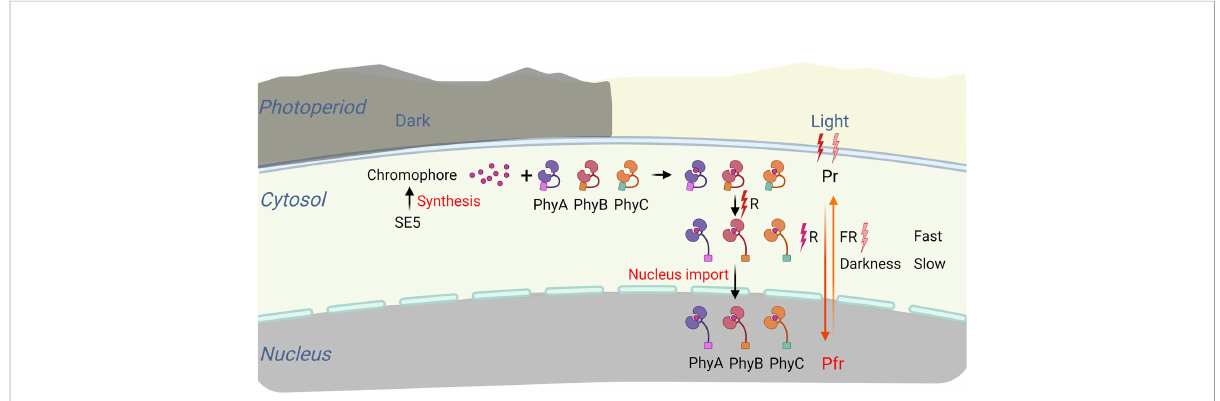
FIGURE 3 Phytochromes import to the nucleus after converting from inactive Pr form to active Pfr form. Phytochromes could change from inactive Pr to active Pfr under Red light (R). The active Pfr can be reverted to the inactive Pr by either a slow reaction caused by darkness or a quick response caused by exposure to far-red light (FR). When the inactive Pr form transforms into the active Pfr form, phytochromes leave their initial location (cytoplasm) and enter the